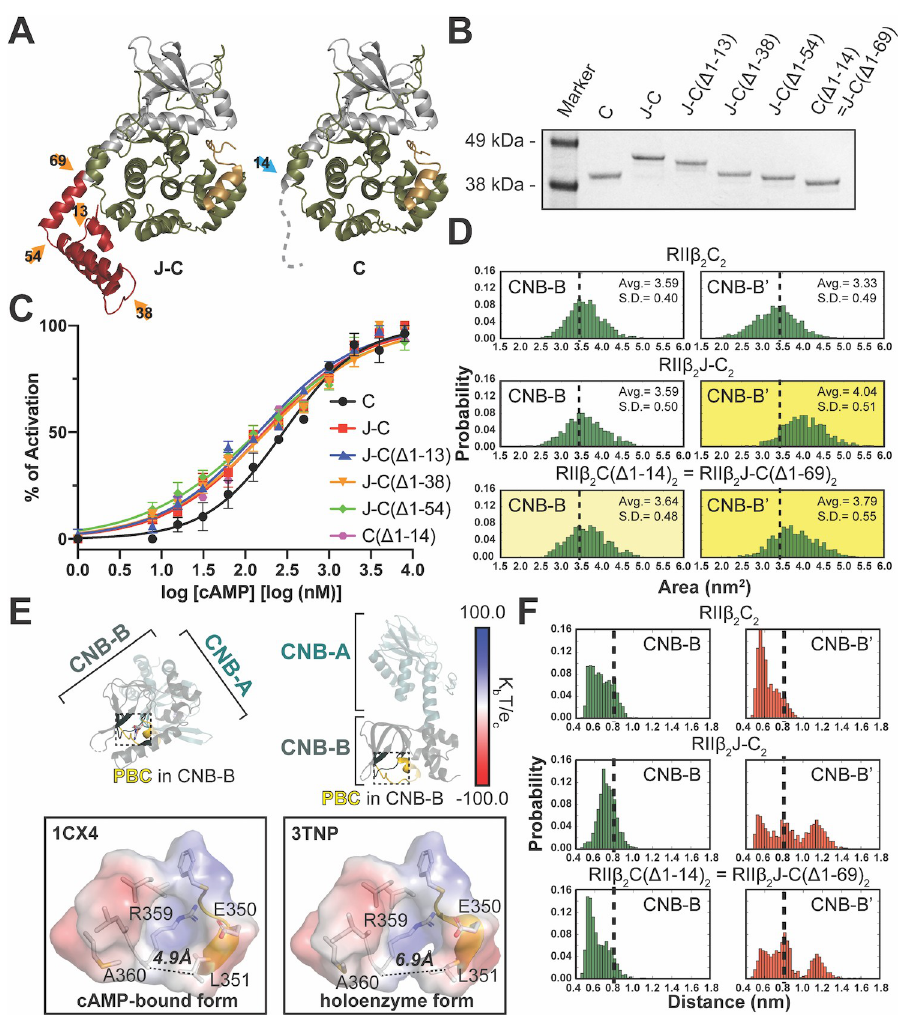
Fig 5. The RII β 2 J-C 2 holoenzyme is easier to activate with cAMP than the RII β 2 C 2 holoenzyme. ( A ) Structure of J-C subunit (left) and C subunit (right). The junctions of 4 helices in J-domain are labeled as orange arrows, where the first exon junction is labeled as blue arrow. ( B ) Coomassie blue staining SDS-PAGE of purified C-, J-C-, J-C( Δ 1–13)-, J-C( Δ 1–38)-, J-C( Δ 1–54)-, and C( Δ 1–14) subunits. C( Δ 1–14) subunit is equivalent to J-C( Δ 1–69) subunit, whole J- domain deletion. ( C ) The fusion protein RII β 2 J-C 2 holoenzyme and its deletion mutants were easier to activate with cAMP than the WT RII β 2 C 2 holoenzyme. n = 2 biological replicate. All error bars represent SEM. ( D ) The CNB-B domains in RII β 2 J-C 2 and RII β 2 C( Δ 1–14) 2 holoenzymes have larger cAMP accessible surface area than RII β 2 C 2 holoenzyme. ( E ) The distance between C β atom in Ala360 RII β and C γ atom in Leu351 RII β in the CNB-B domain of cAMP-bound (left, PDB = 1CX4) and holoenzyme (right, PDB = 3TNP) forms. ( F ) The distance population probability of the PBC pocket in RII β 2 C 2 , RII β 2 J-C 2 , and RII β 2 C( Δ 1–14) 2 holoenzymes. The CNB-B domains in the RII β 2 J-C 2 and RII β 2 C( Δ 1–14) 2 holoenzymes are more prone to open than the RII β 2 C 2 holoenzyme. Both of the RII β 2 J-C 2 and RII β 2 C( Δ 1–14) 2 holoenzymes reveal intrinsic asymmetry in the CNB-B domains. The data used to make these figures can be found in S1 Data. CNB, cyclic nucleotide binding; PDB, Protein Data Bank; SEM, standard error of the mean; WT, wild-type.